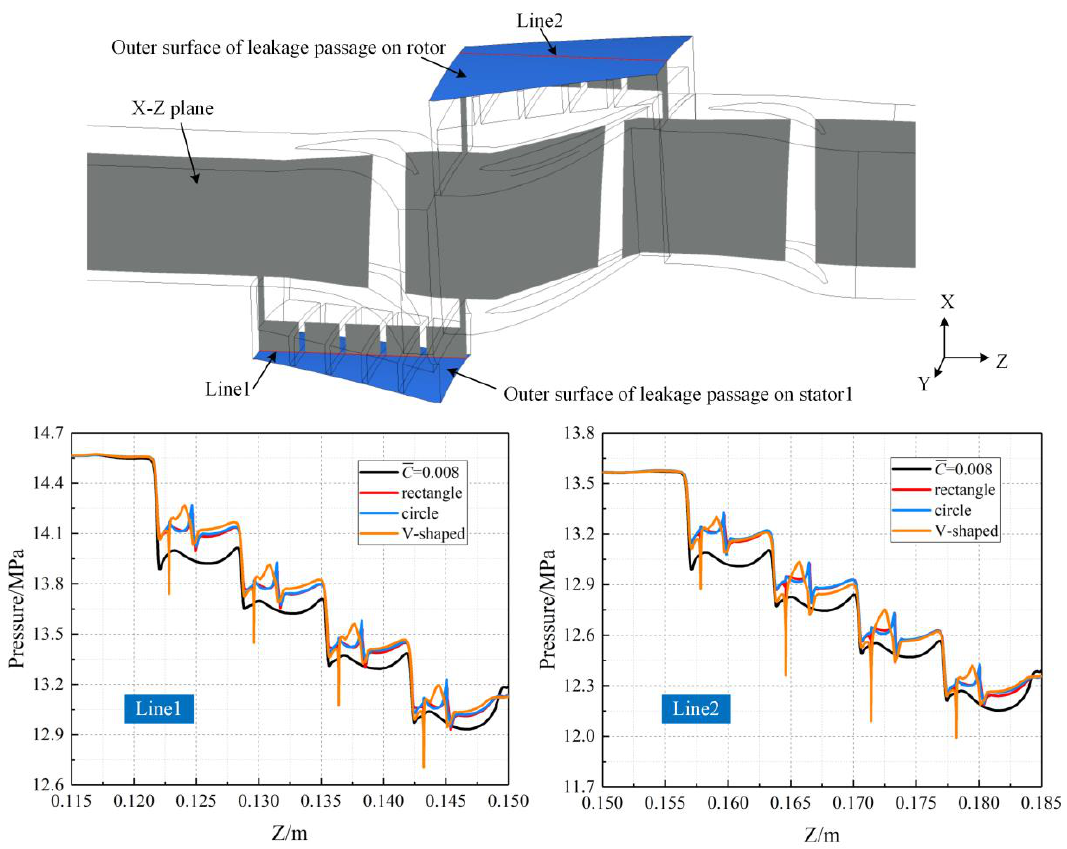
Figure 13. The distributions of pressure in leakage passage along axial direction under different groove on the cavity surface.